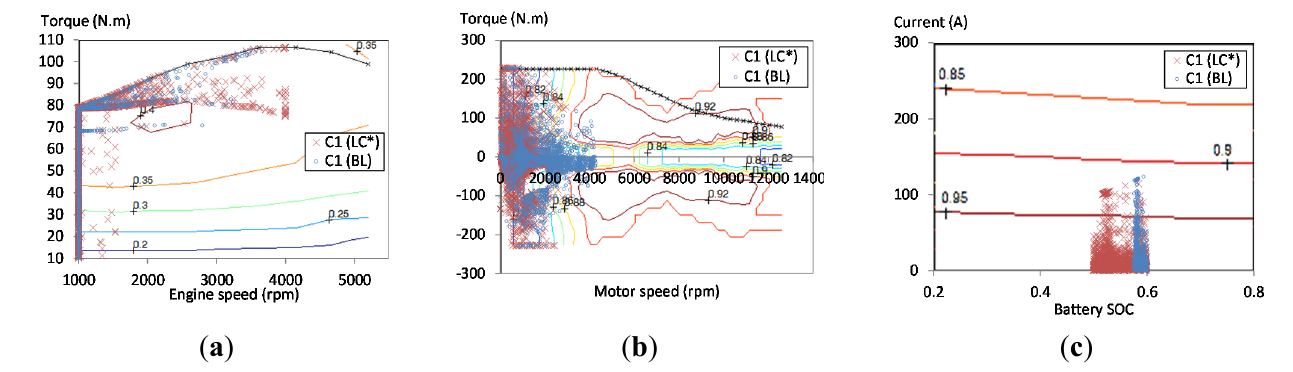
Figure A4. Plots of C1 solution engine ( a ), electric motor ( b ), and battery ( c ) operation for BL and LC driving cycles. (* driving cycle used in the optimization).